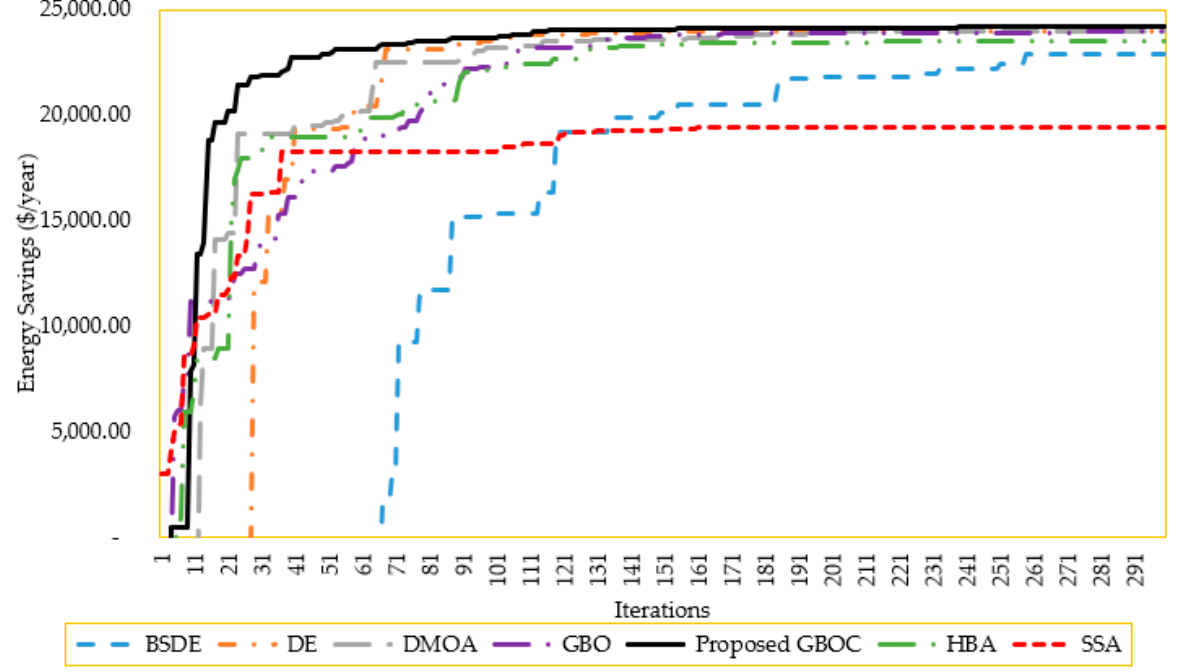
DMOA, DE, and HBA for Scenario 2.